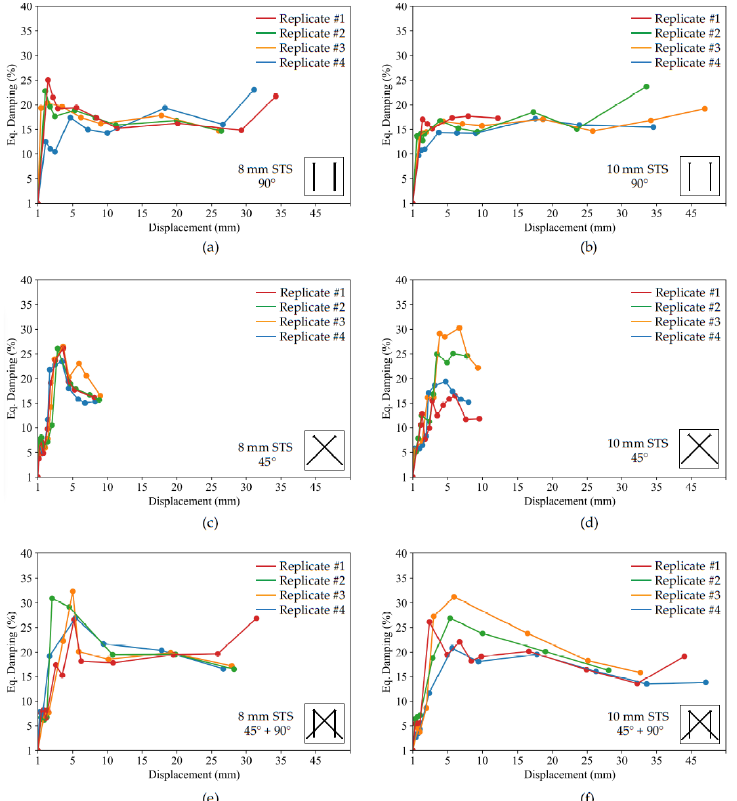
Figure 8. Equivalent viscous damping ratio of STS connections under reversed-cyclic loading: ( a ) 8 mm STS at 90°; ( b ) 10 mm STS at 90°; ( c ) 8 mm STS at 45°; ( d ) 10 mm STS at 45°; ( e ) 8 mm STS at mixed angles (45° and 90°); and ( f ) 10 mm STS at angles (45° and 90°). 4. Conclusions Forty-eight self-tapping screw (STS) connections used to connect a CLT core to light- frame wood floor headers were tested under monotonic and reversed-cyclic load to inves- tigate the strength, stiffness, ductility, and energy dissipation capacity of the connections. Three types of STS insertion angles were tested and compared: 45 ° , 90 ° , and mixed angles (90 ° and 45 ° ). The results showed that all configurations of the connections have accepta- ble lateral load capacity and ductility. Furthermore, the connections with mixed angle STSs possessed high stiffness, ductility, and energy dissipation capacity and can be an